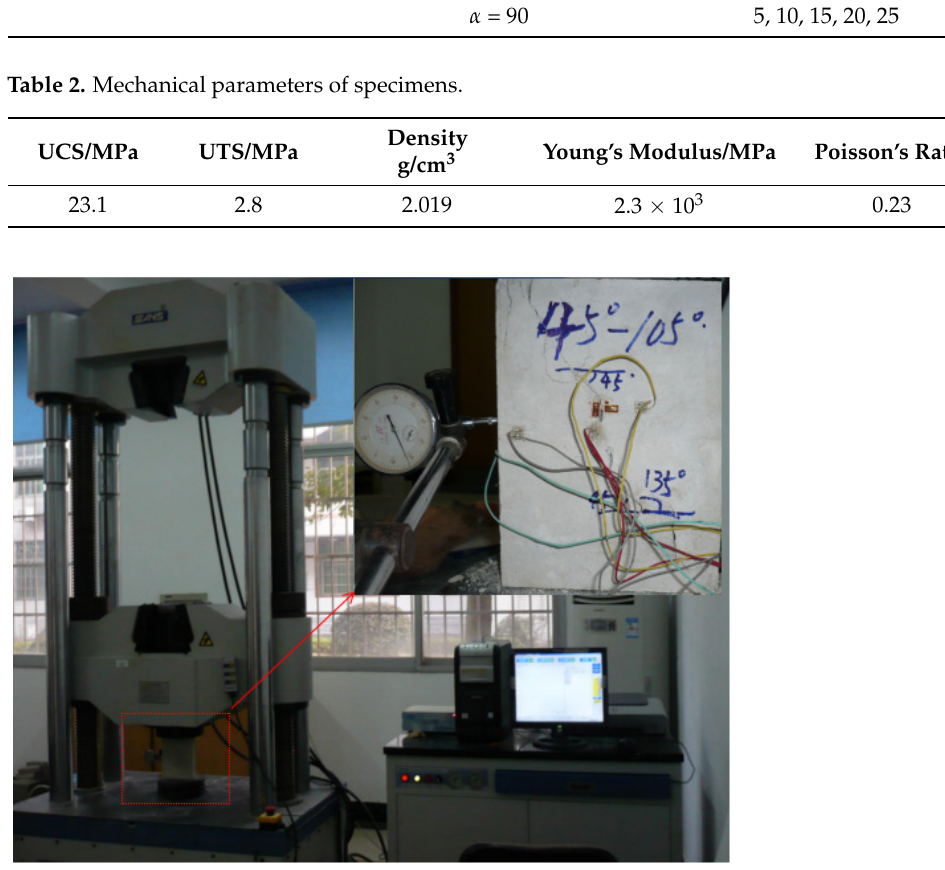
Figure 2. Experimental setup for multiple-fractured rock-like